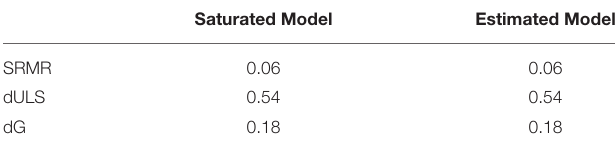
TABLE 3 | Goodness of fit